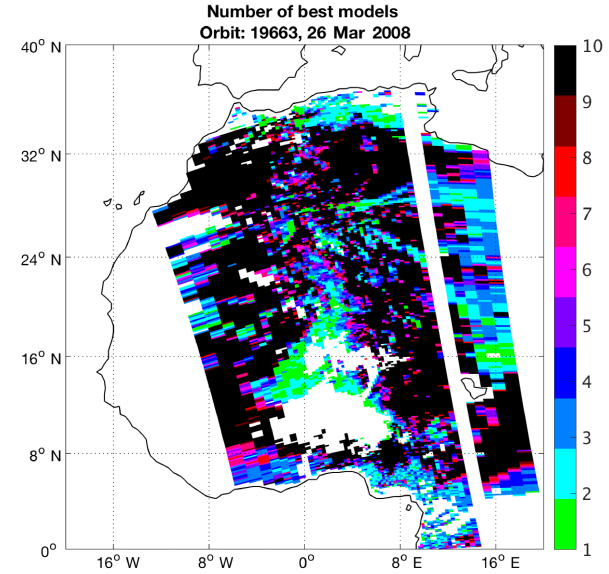
Figure 9. The number of most appropriate aerosol microphysical models at the retrieved pixels.